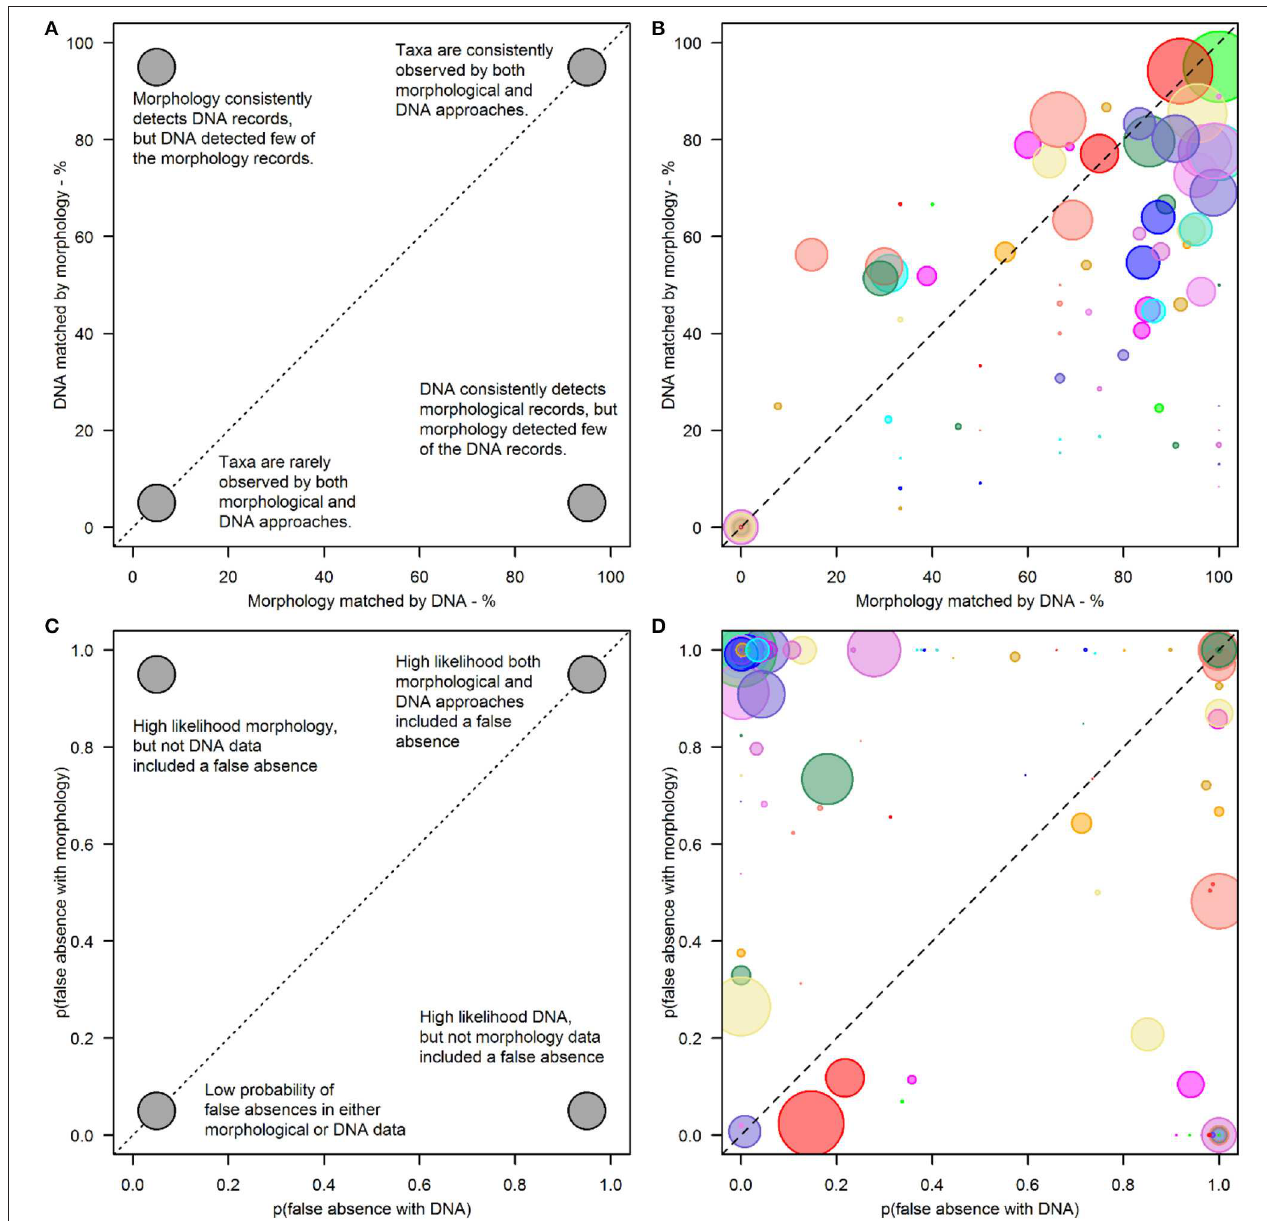
FIGURE 4 | Comparison of macroinvertebrate families ( n = 114) observed in pairs of standard 3-min river benthos kick samples ( n = 141 sites). (A,B) Shows the correspondence between observations of each taxonomic family using either morphological identification or DNA metabarcoding. Points are scaled relative to the number of morphological observations. (C,D) Shows the probability that each method included at least one false absence for each taxon (see Supplementary Material S2 for code and raw data).